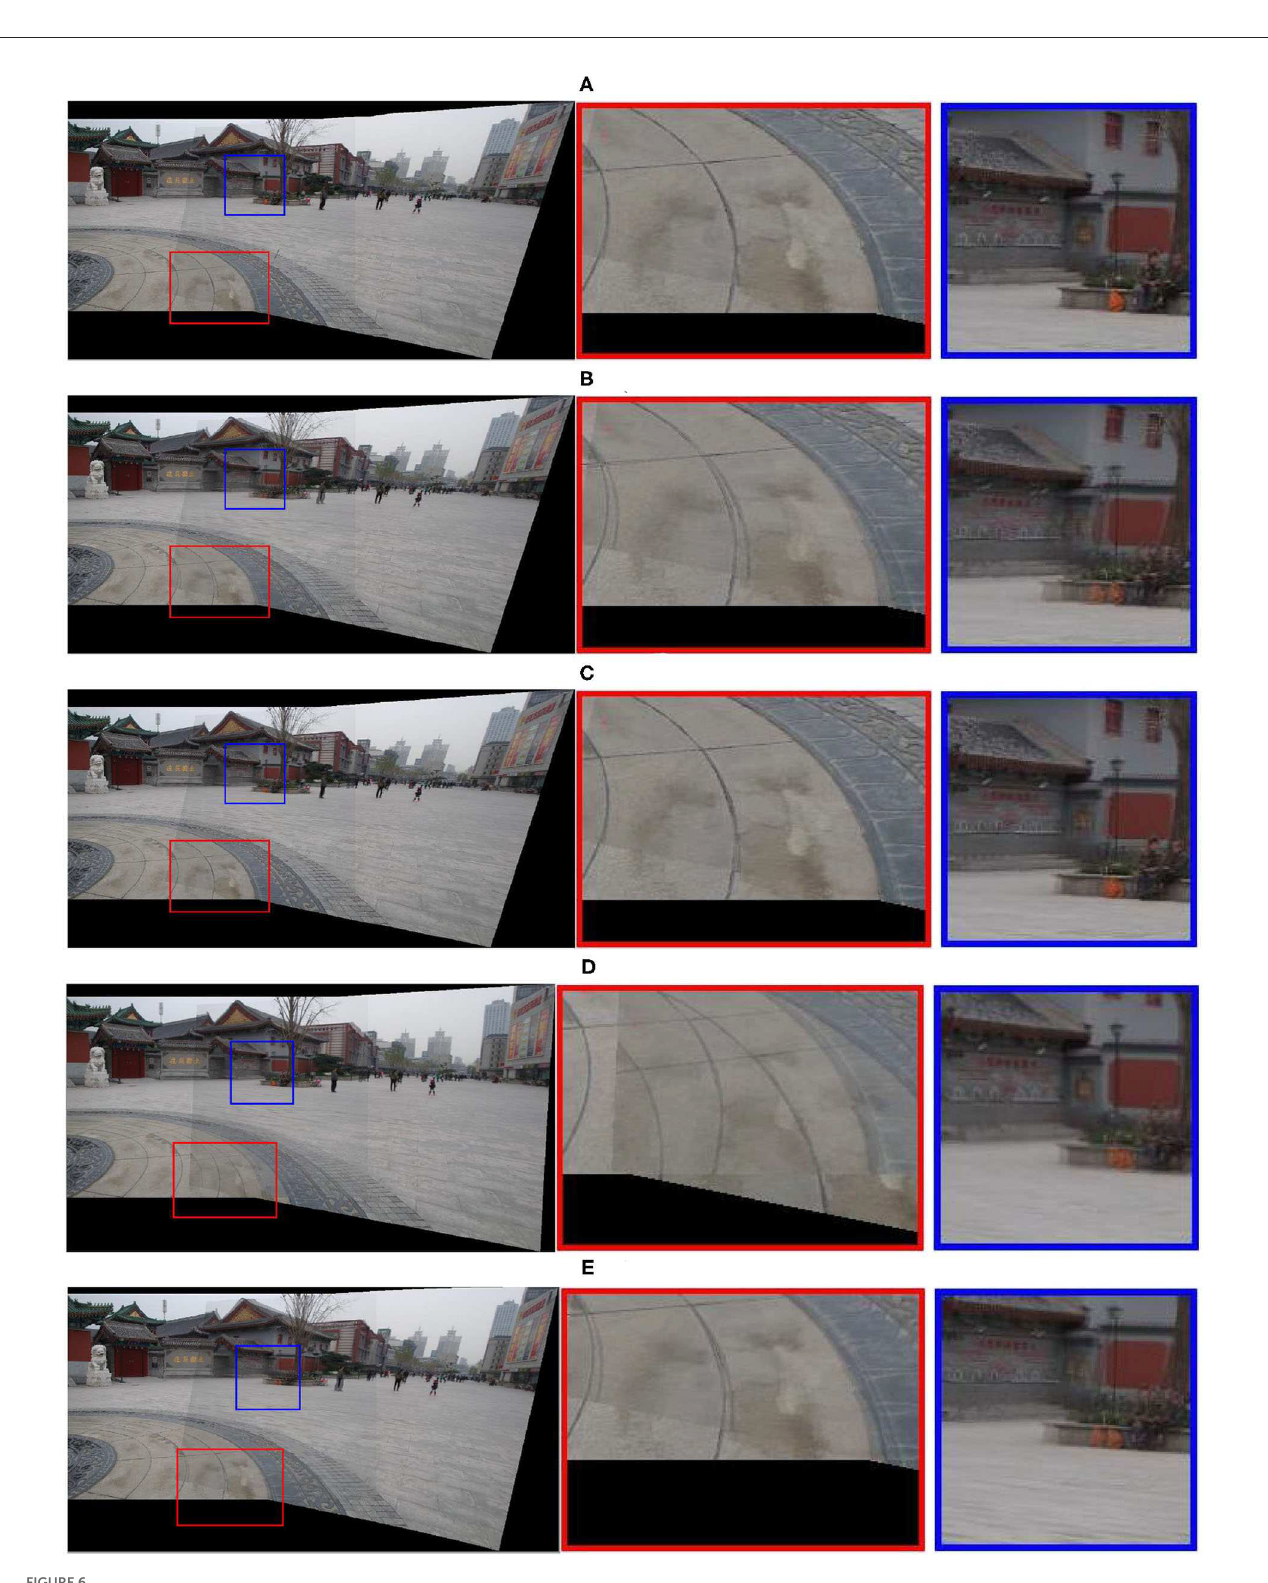
FIGURE6 Comparisons with state-of-the-art image stitching techniques on the Temp image dataset. From top to bottom, each row is (A) our method, (B) global homography, (C) APAP, (D) AutoStich, and (E) SPW. The red boxes and blue boxes show the stitching details clearly